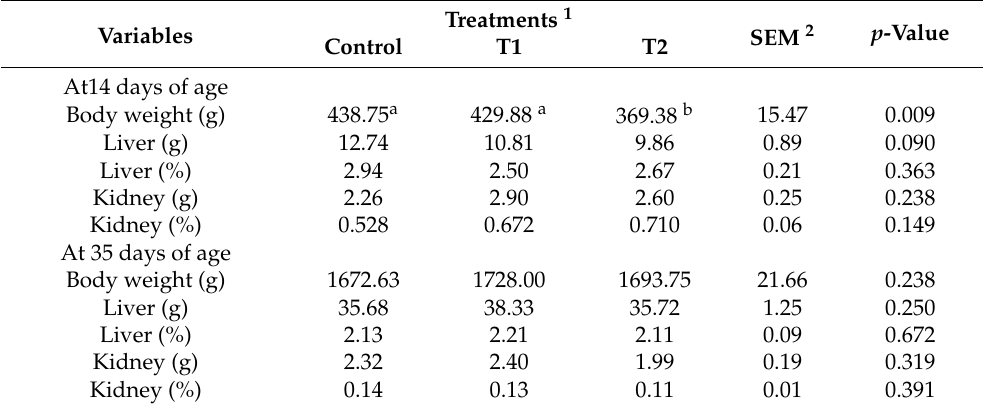
Table 5. Effect of Tribulus Terrestris (TT) supplementation on absolute and relative weight of liver and kidney in broiler